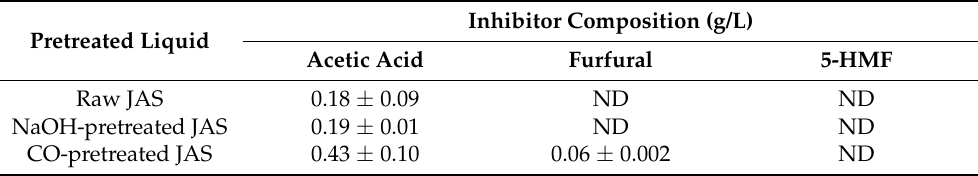
Table 3. Inhibitor composition of hydrolysate from the different pretreatment JASs.